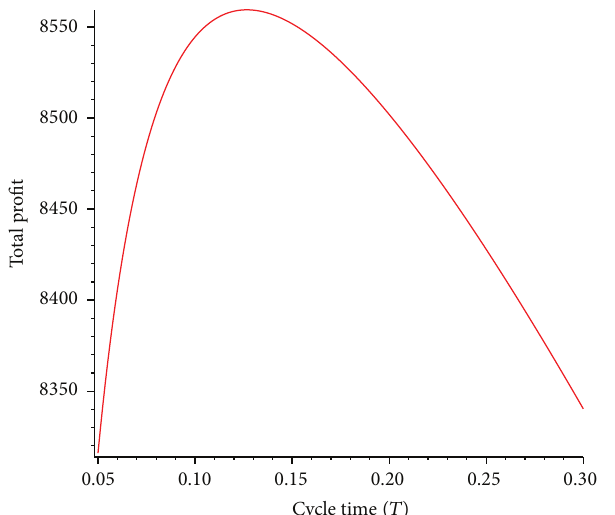
Figure 4: Sensitivity analysis for cycle time ( 𝑇 ).